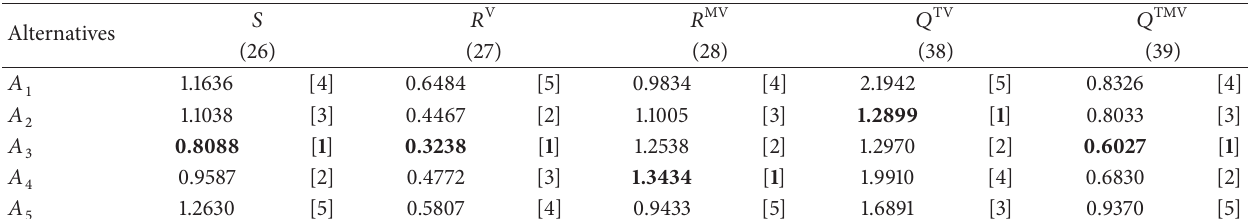
Table 11: Ranking of alternatives with respect to values of 𝑆 , 𝑅 V , 𝑄 TV , 𝑄 TMV , and 𝑄 TMV .